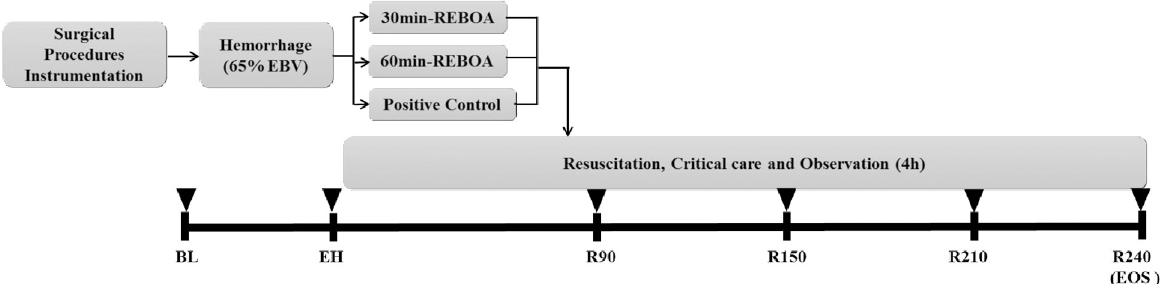
Fig 1. Overview of experimental design. BL, baseline; EBV, estimated blood volume; EH, end of hemorrhage; EOS, end of study; R90, R150, R210 and R240 are 90-, 150-, 210-, and 240-min post-resuscitation, respectively; cREBOA, complete resuscitative endovascular balloon occlusion of the